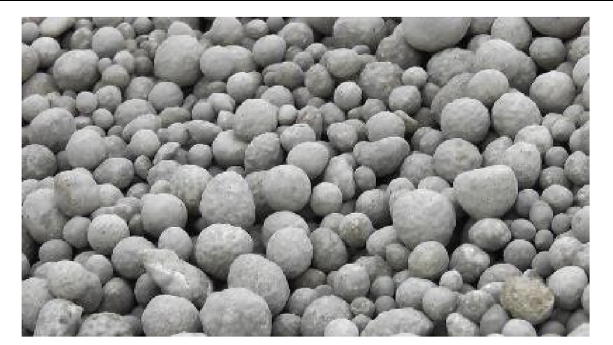
FIGURE 2 | Manufactured carbonated aggregate < 14 mm (courtesy of Carbon8 Systems,